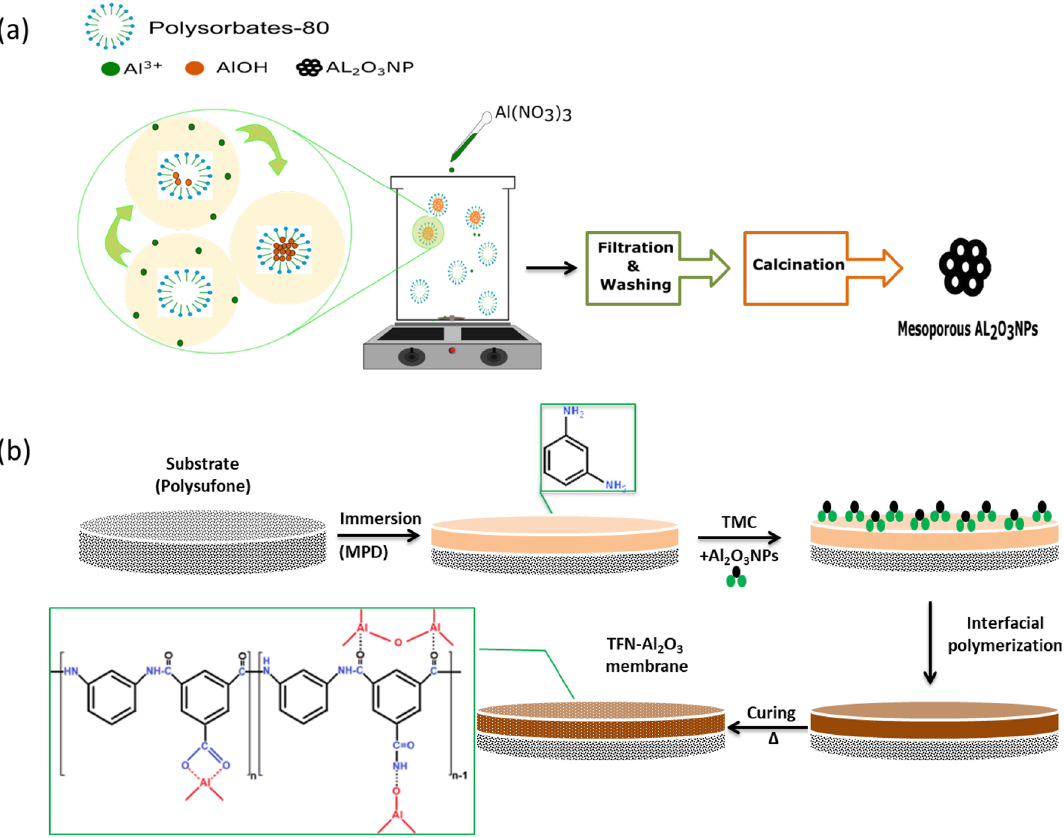
Figure 1. Fabrication steps of ( a ) mesoporous γ-Al 2 O 3 NPs and ( b ) TFN-Al 2 O 3